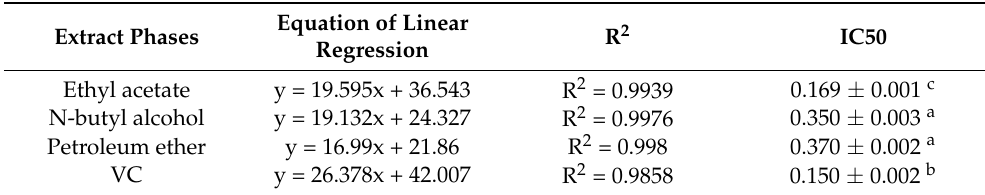
Table 9. Scavenging effect of Pleioblastus amarus (Keng) shell with different extraction phases on ABTS+ free radical. Equation of Linear Extract Phases R 2 IC50 Regression Ethyl acetate y = 19.595x + 36.543 Petroleum ether y = 26.378x + 42.007